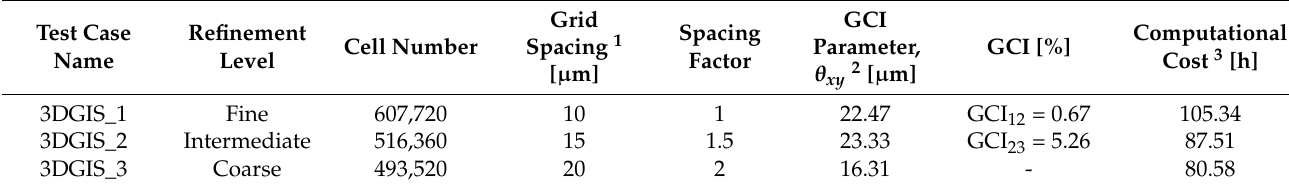
Table 4. 3D grid independence